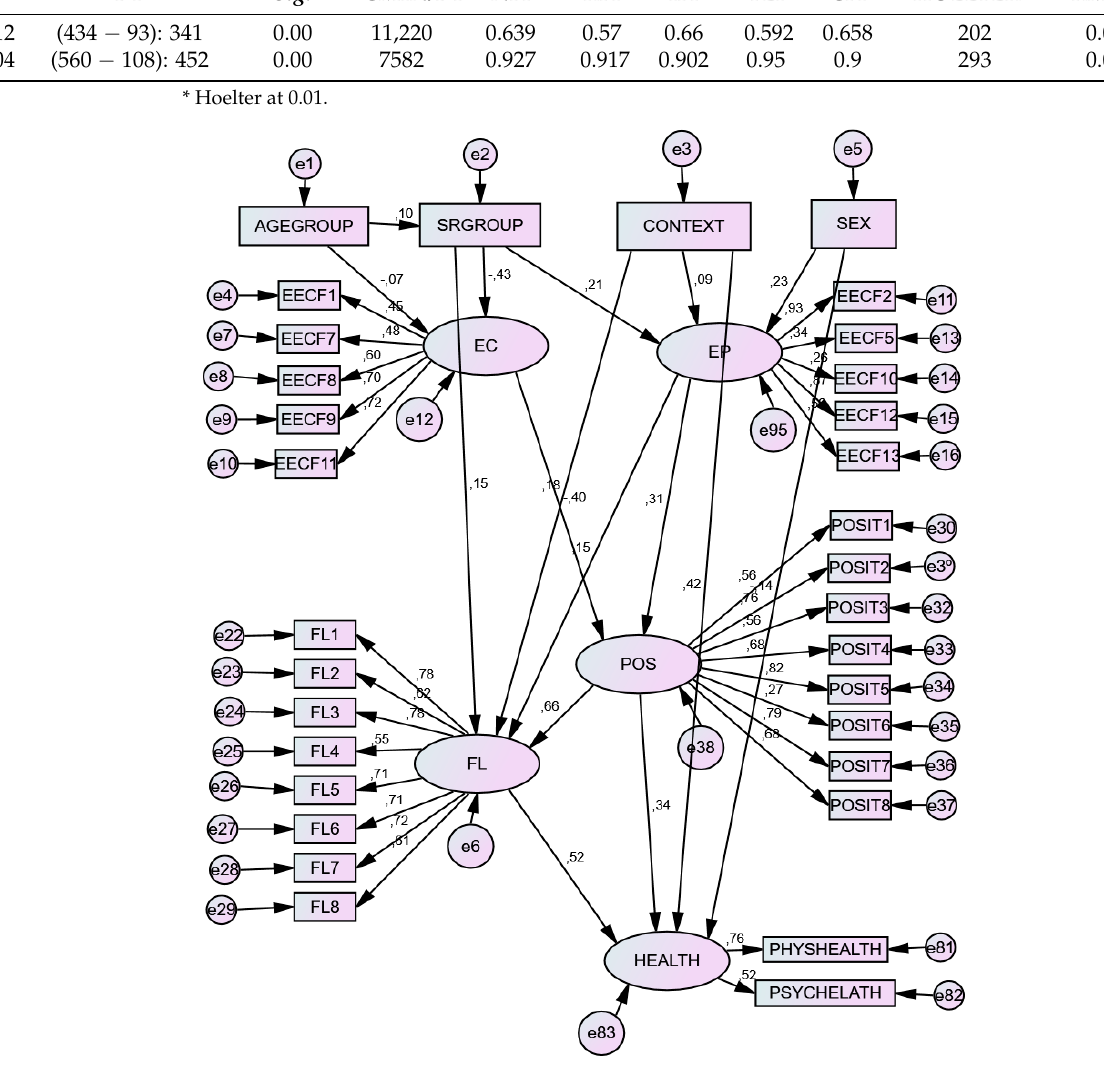
Figure 2. Predictive structural relationship of self-regulation level, educational context, age, and gender on coping strategies, positivity, and well-being outcomes. Note. SRGROUP = self-regulation group; CONTEXT = educational context; EC = emotion-focused coping; EP = problem-focused coping; POS = positivity; FL = flourishing; HEALTH = behavioral health; PHYSHEALTH = physical health; PSYHEALTH = psychological